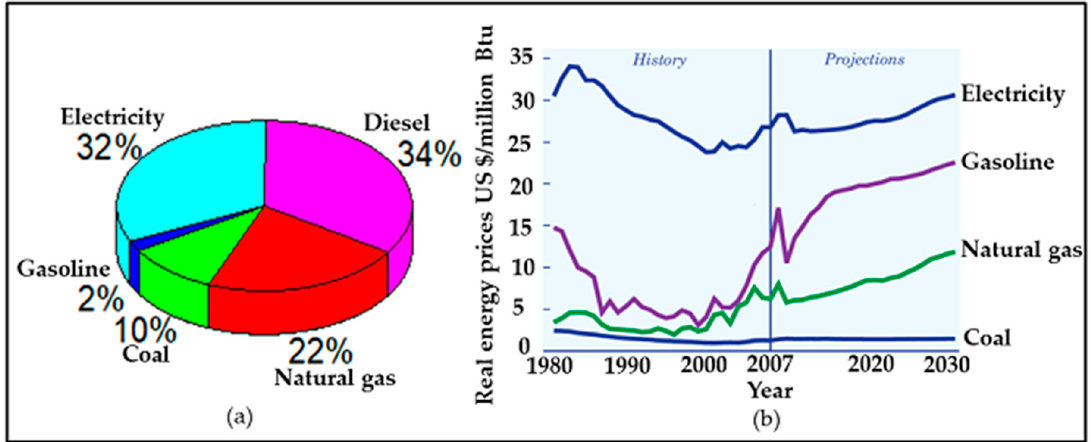
Figure 1. ( a ) Mining operations energy sources (data sources: [13,15]). ( b ) Energy costs trend [16].